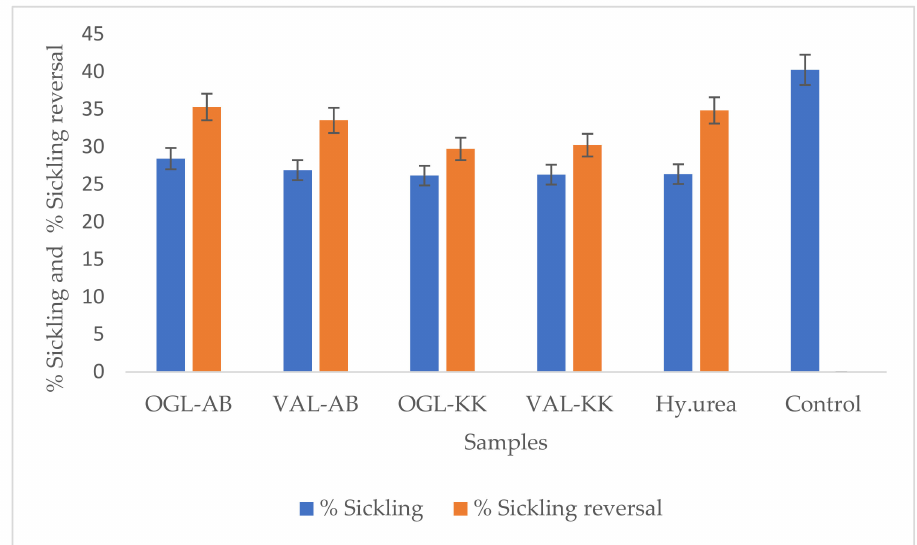
Figure 6. Percentage sickling reduction and sickling reversal of erythrocytes treated with 10 mg/mL extracts. VAL—Vernonia amygdalina leaves from Kokori; OGL-AB—Ocimum gratissimum leaves from Abraka;